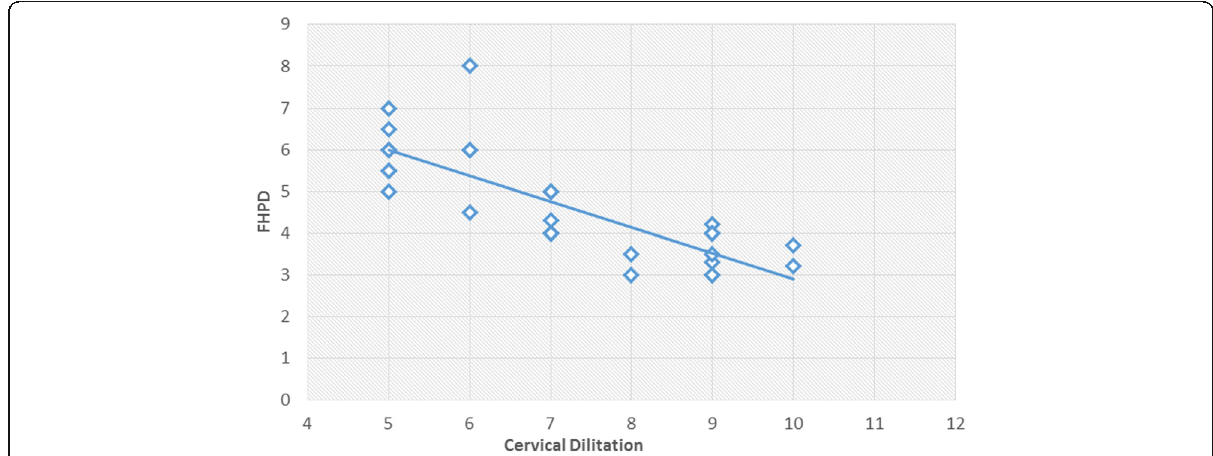
Fig. 5 Correlation between cervical dilatation and